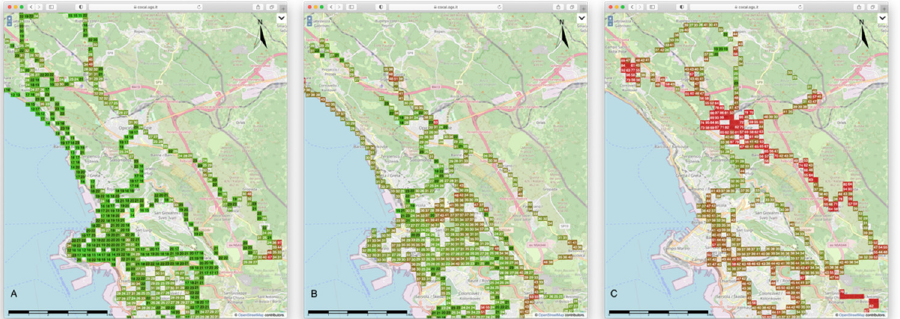
Figure 7. Snapshots from the COCAL web portal showing the distribution of PM measurements in the designated area during the experiment. For ease of reading, data are gathered in 4 h intervals ( A ) 9 a.m. to 1 p.m., ( B ) 1 p.m. to 5 p.m., ( C ) 5 p.m. to 9 p.m.